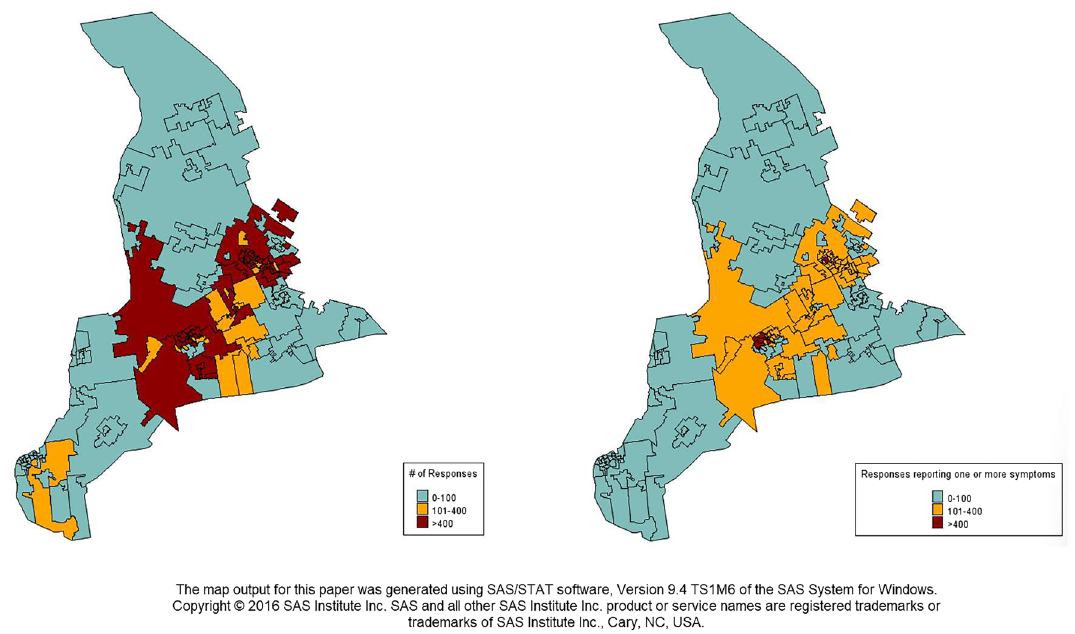
Figure 4. Geo-spatial distribution of portal responses and presence of at least COVID-19 related symptoms by